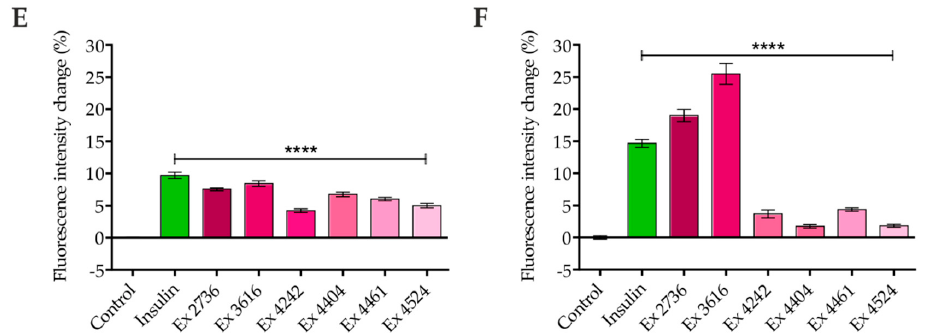
Figure 1. Glucose transporter 4 (GLUT4) translocation quantitation by objective-type scanning total internal reflection fluorescence (TIRF) microscopy. CHO-K1 ( A , C , E ) and HeLa ( B , D , F ) cells stably expressing a GLUT4-myc-GFP fusion protein were seeded in 96-well microtiter plates and starved for 3 h in HBSS buffer on the following day. Images in the TIRF configuration were taken before and after stimulation with insulin for 10 ( A ) or 20 min ( B ). Insulin dose–response curves were generated by quantitation of the fluorescence signal intensity increase induced by various insulin concentrations in both cell lines ( C , D ). Six different plant extracts were tested for their insulin mimetic properties ( E , F ). Values represent the mean ± SEM ( n > 500). **** p < 0.0001 indicates statistically significant differences from the untreated controls.